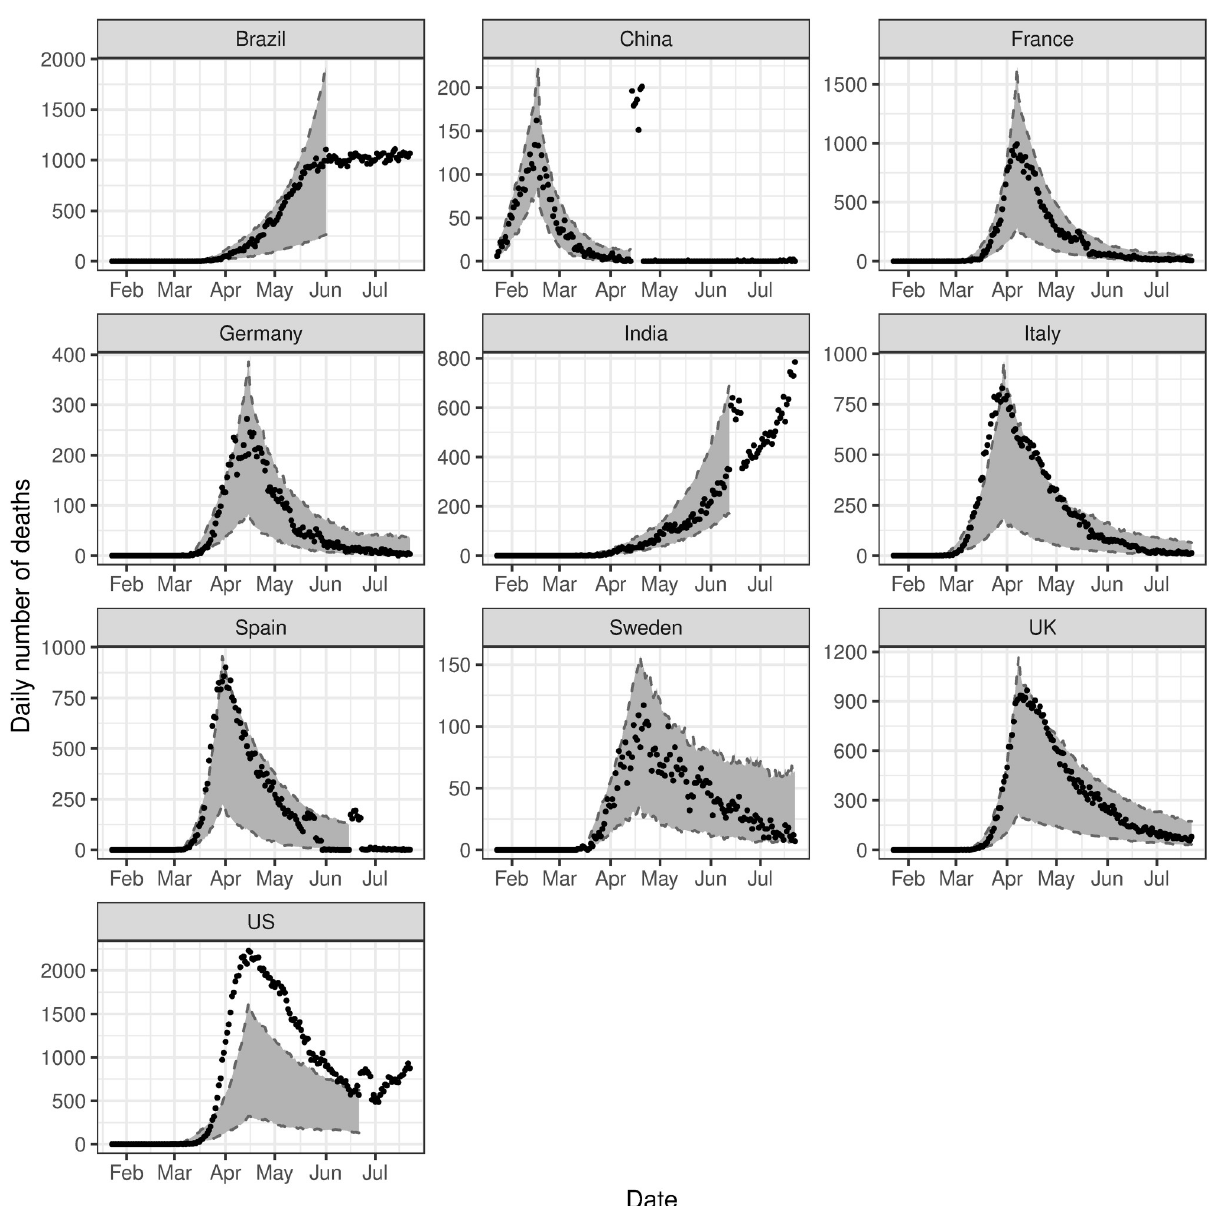
Fig 3. In-sample validation. The observed number of deaths (black dots) compared to the 95% posterior predictive interval for the estimated expected number of events, i.e. λ ( t ) (grey ribbon).